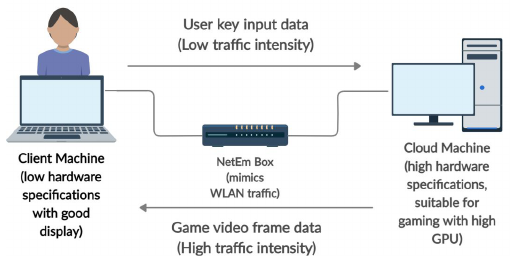
Figure 4. QoE Experiment